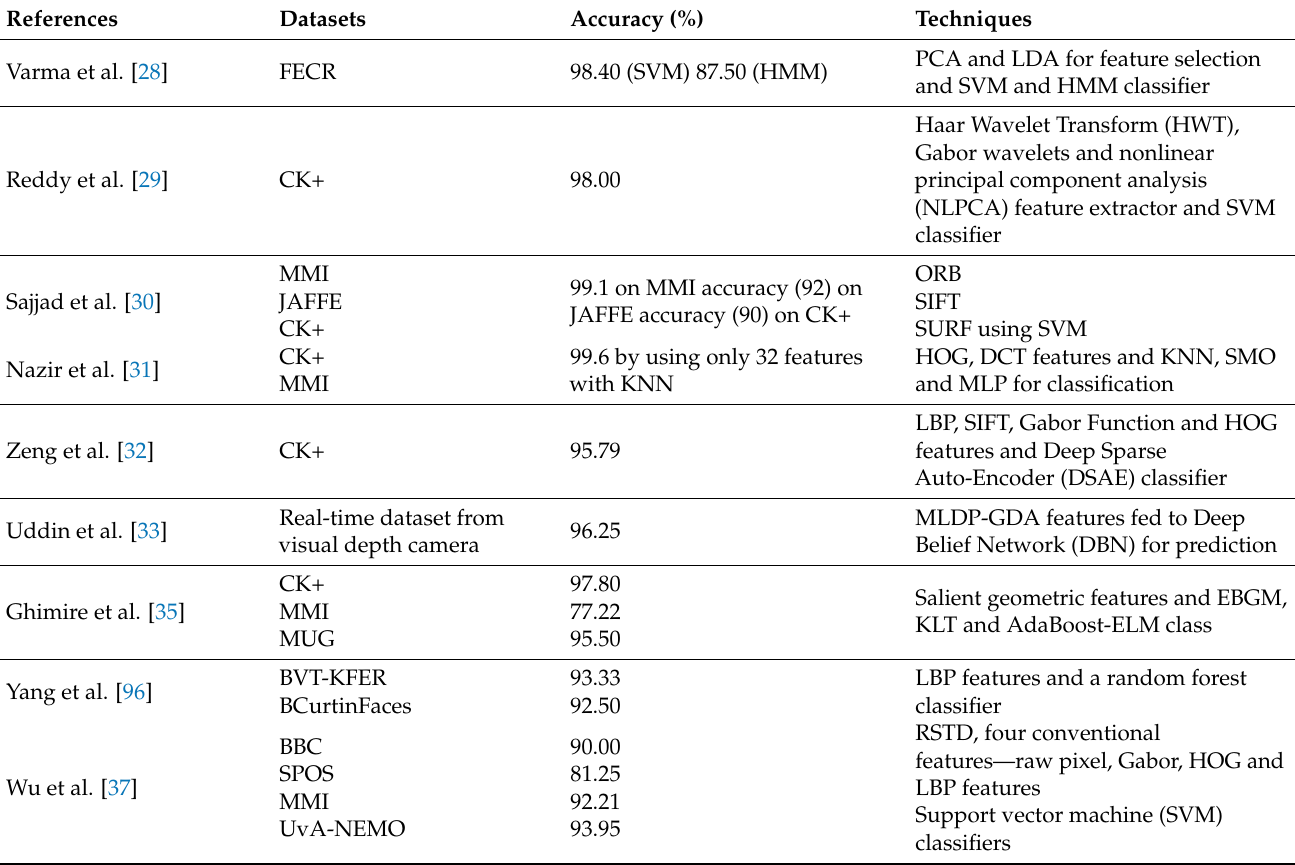
Table 3. Conventional ML-based approaches for